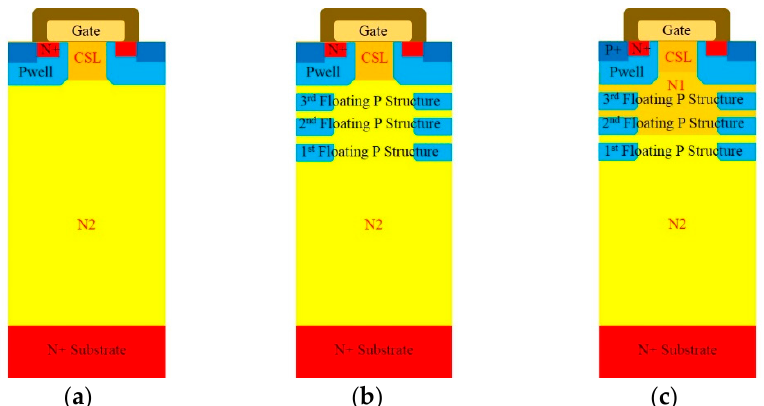
Figure 1. Three device structure schematic diagrams ( a ) traditional vertical MOSFET, ( b ) FSJ MOSFET, ( c ) DC-FSJ MOSFET.